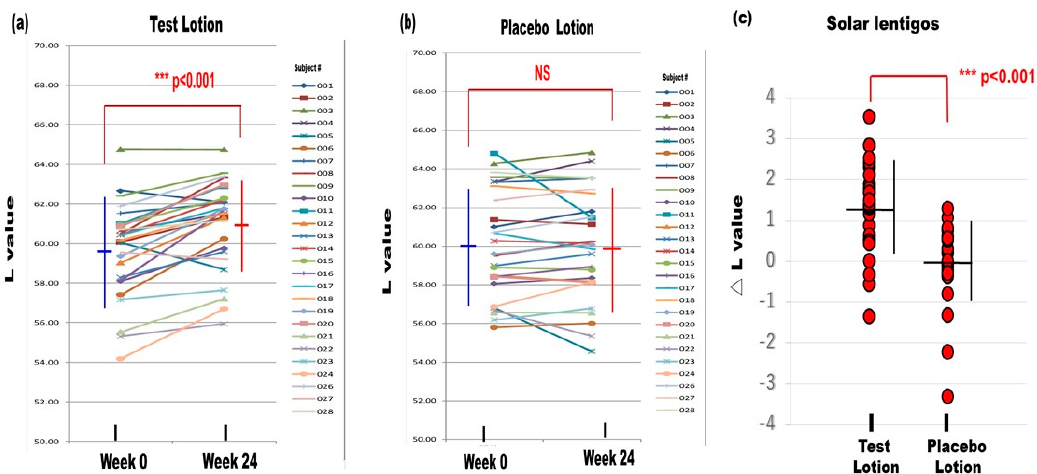
Figure 9. Changes in the L values of SLs after treatment for 24 weeks [45]. ( a ) Test lotion, N = 27, ( b ) Placebo lotion, N = 27, ( c ): △ L values between weeks 0 and 24. N = 27, *** p < 0.001.